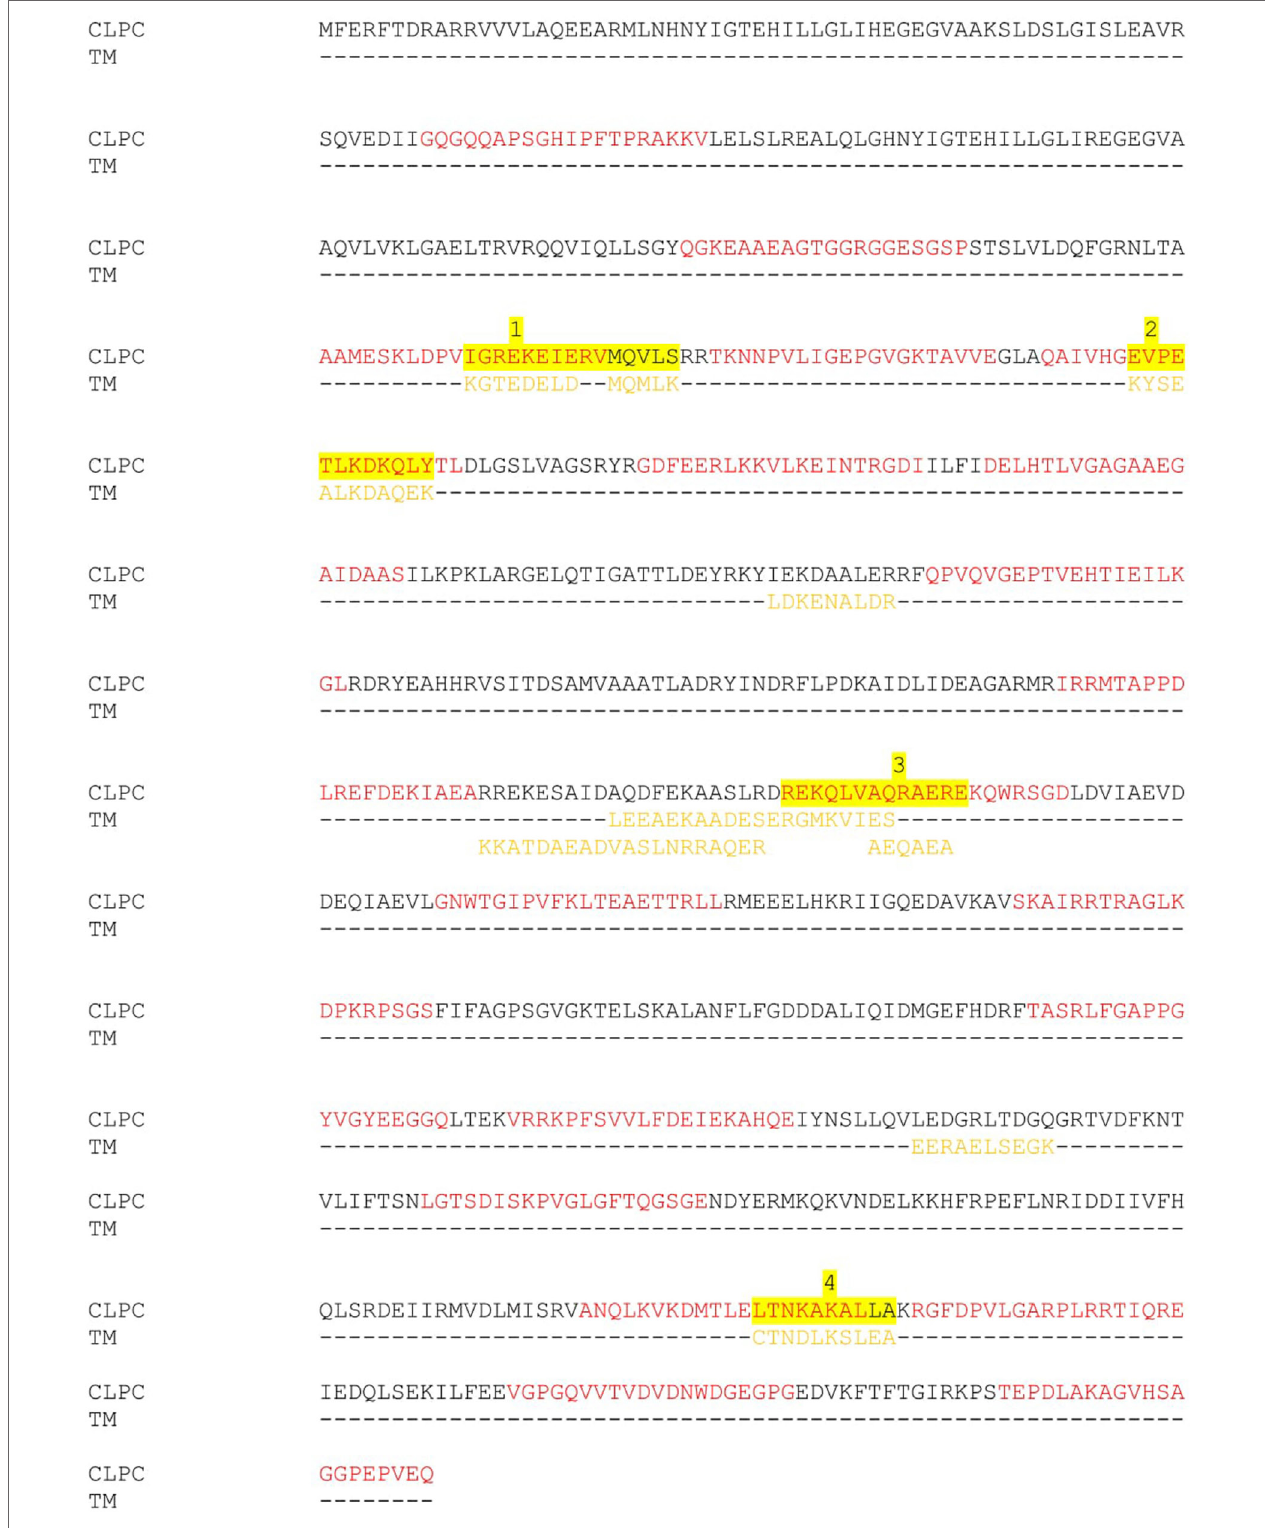
FigUre 7 | Multiple sequence alignment of Probable ATP- dependent clp protease ATP-binding subunit (CLPC) of Mycobacterium leprae and B cell epitopes of tropomyosin (TM) of host. Red color—showing predicted B cell epitopes of CLPC of M. leprae . Purple color—showing predicted B cell epitopes of tropomyosin of host. Yellow color—highlighted sequences showing mimicking B cell epitopes of both the